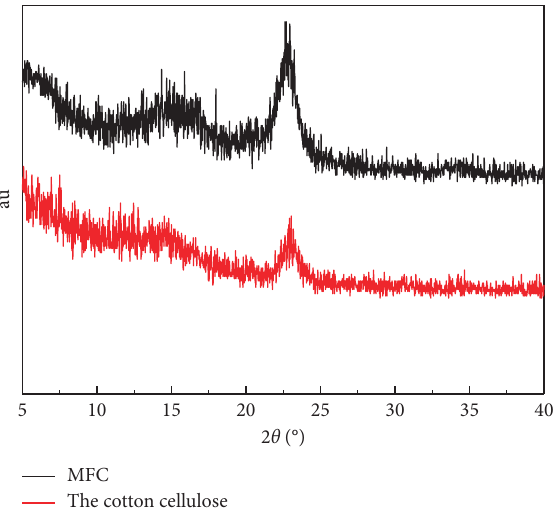
Figure 7: XRD patterns of MFC and cotton